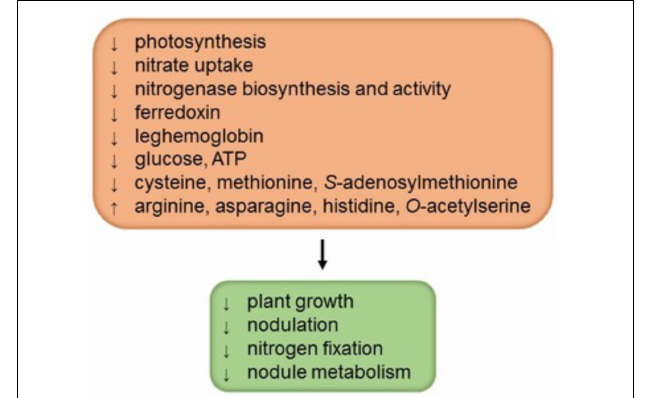
FIGURE 1 | Sulfur deficiency negatively affects the performance of nodulated legumes. The scheme depicts four major general effects in interaction, as well as some specific biochemical features that may, at least in part, account for such effects. Information was gathered from studies by Anderson and Spencer (1950), DeBoer and Duke (1982), Zhao et al. (1999), Scherer (2008), and Varin et al.